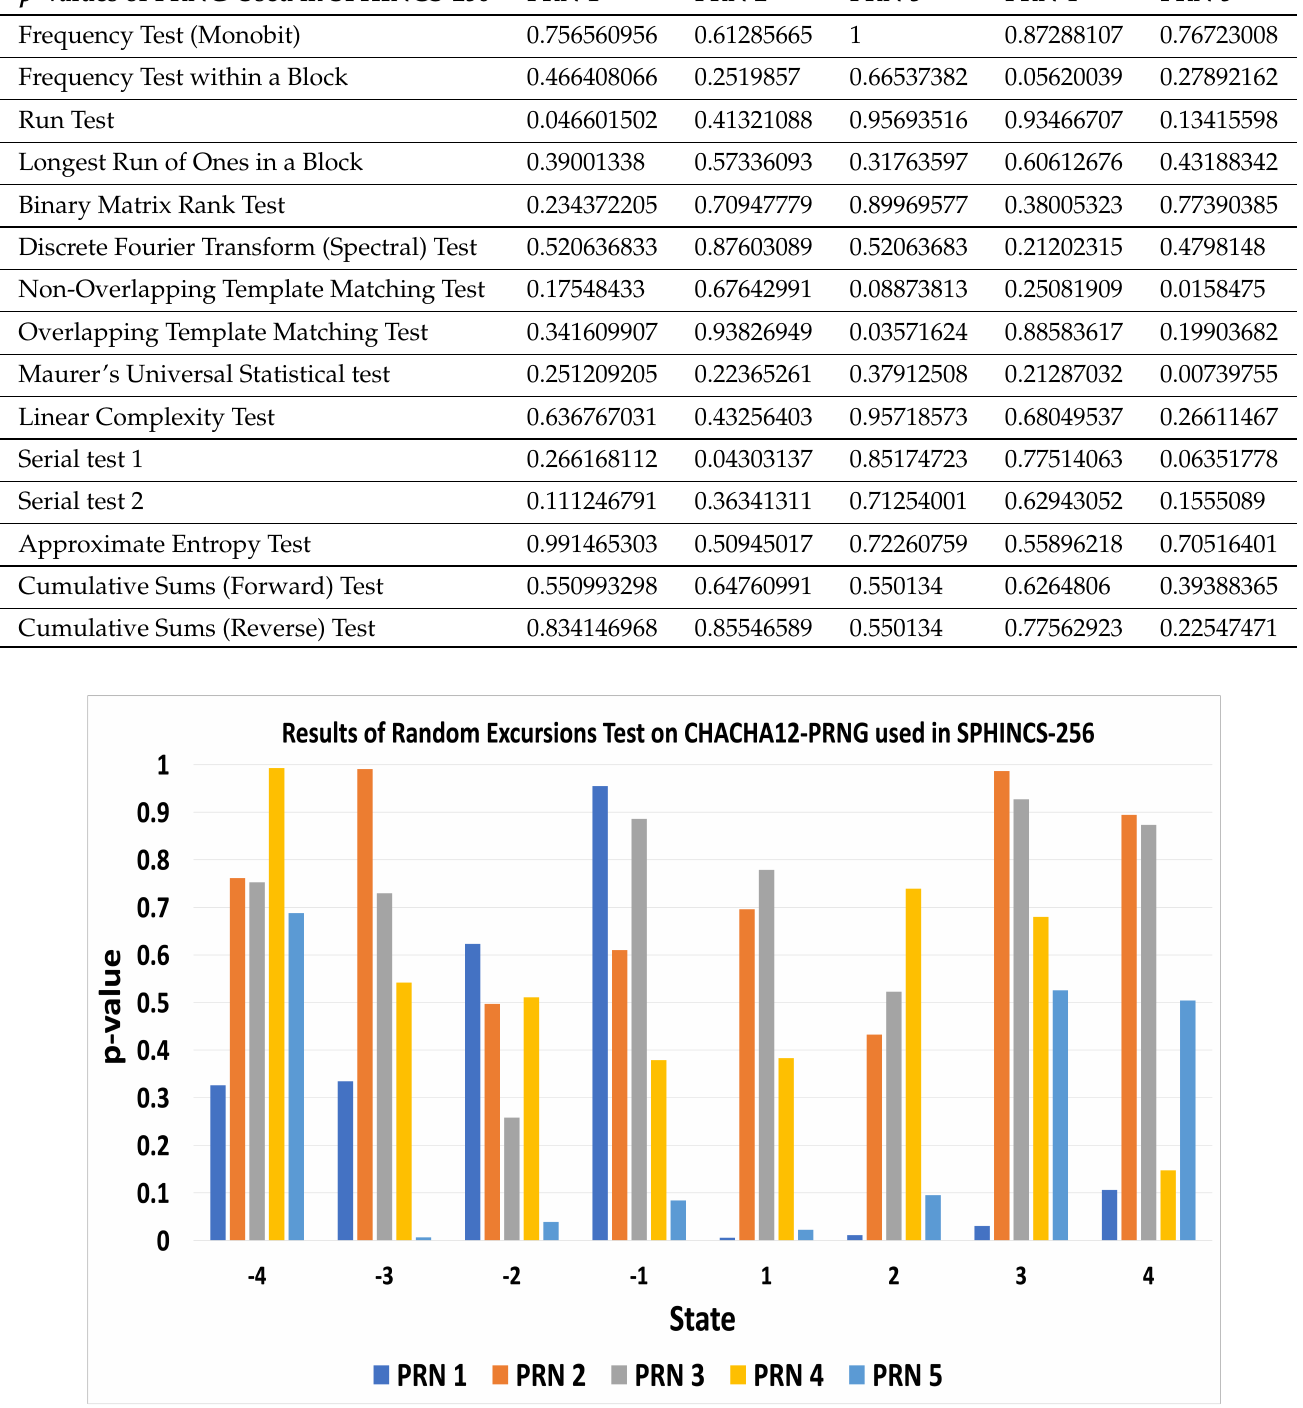
Figure 19. Results of Random Excursions Test on Chacha-12 PRNG used in